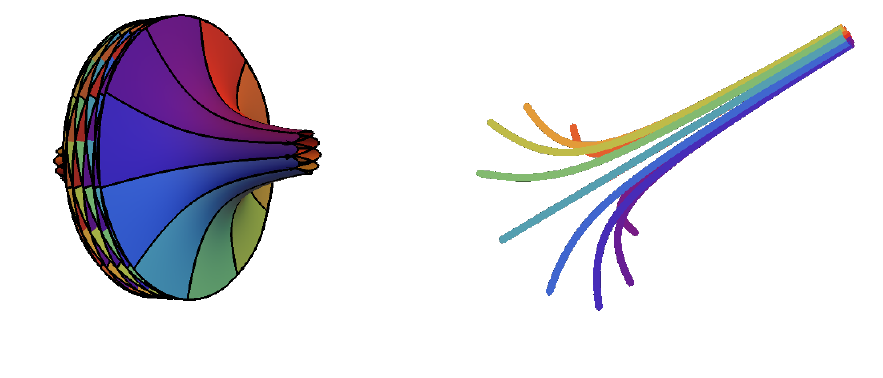
Figure 1 . A plot of N = 10 strands, projected from four dimensions down to ( w 1 ; w 2 ; z 2 ), with C = 0 : 1. To the left the strands are plotted in their complete form, while on the right we have chosen to plot each strand along a single line only. In both pictures the strands separate into a disk in the w -plane. The cylindrical pole (which we have made more pronounced in the right picture) is the remainder of the z -plane after the projection down to three dimensions along its imaginary part. At the core of the pole, where all the strands merge, the non-Abelian description is reliable; as the strands open up, the Abelian picture takes over. Each of the strands are individually colored, and their misalignment is caused by the phase